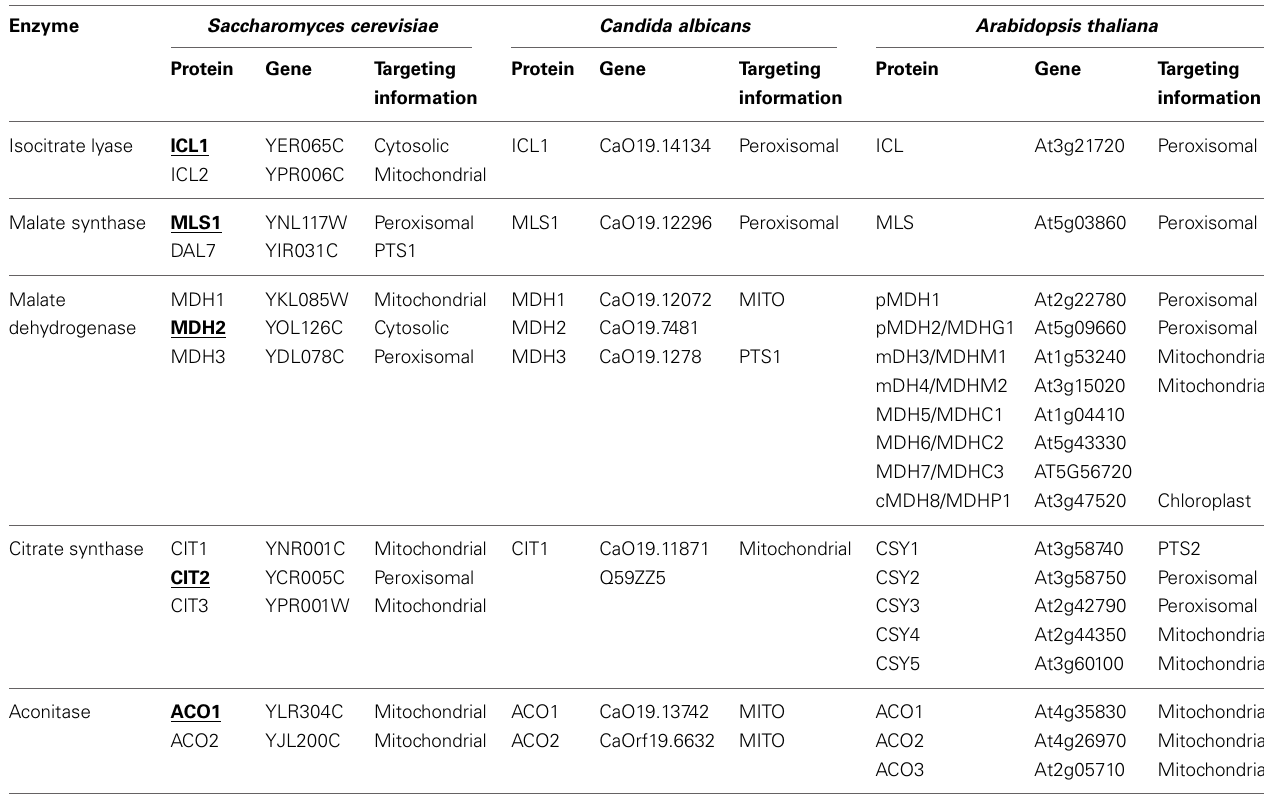
Table 1 | Enzymatic activities required for the glyoxylate cycle.